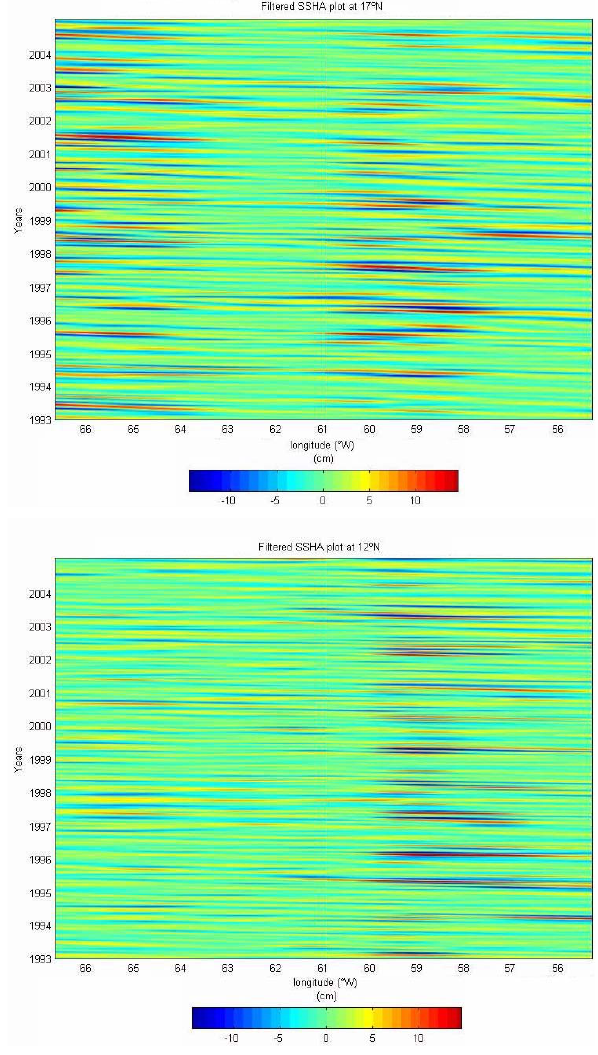
Figure 5. Hovmöller diagrams at 17ºN (top) and 12ºN (bottom) after band-pass filtration. Fig. 5. Hovm¨oller diagrams at 17 ◦ N (top) and 12 ◦ N (bottom) after bandpass (1–6 months)